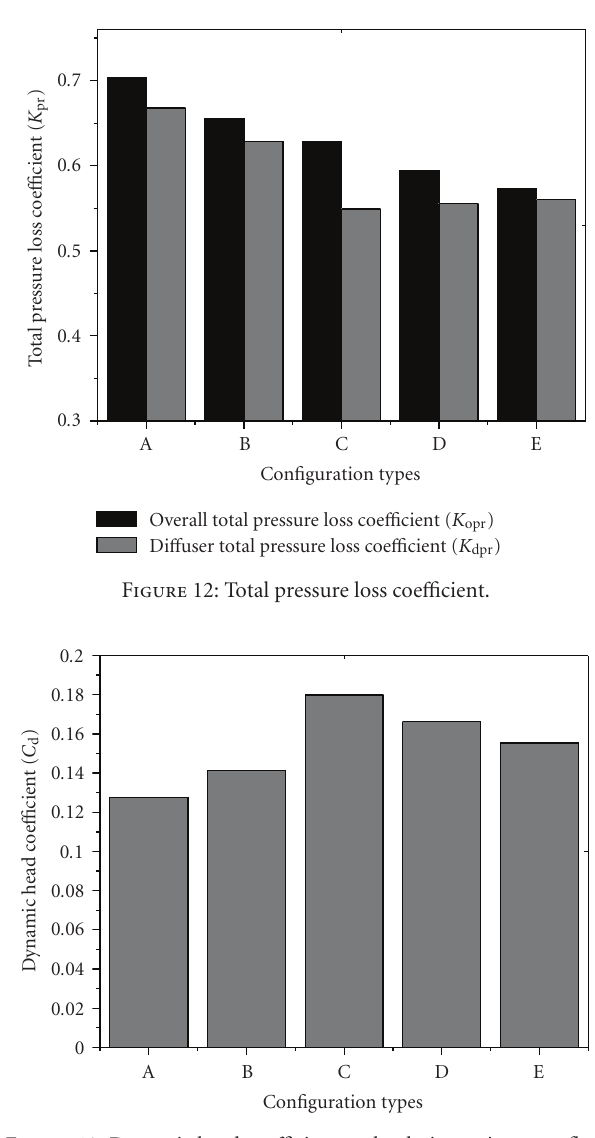
Figure 13: Dynamic head coe ffi cient at the design point mass flow rate of configuration C (inlet velocity of